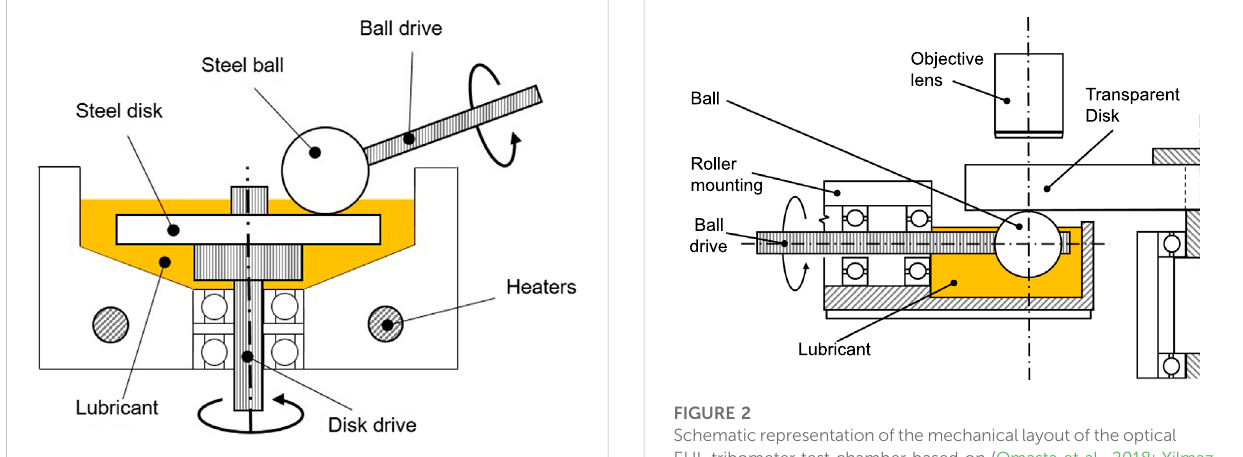
FIGURE 1 Schematic representation of the mechanical layout of the MTM2 test chamber.